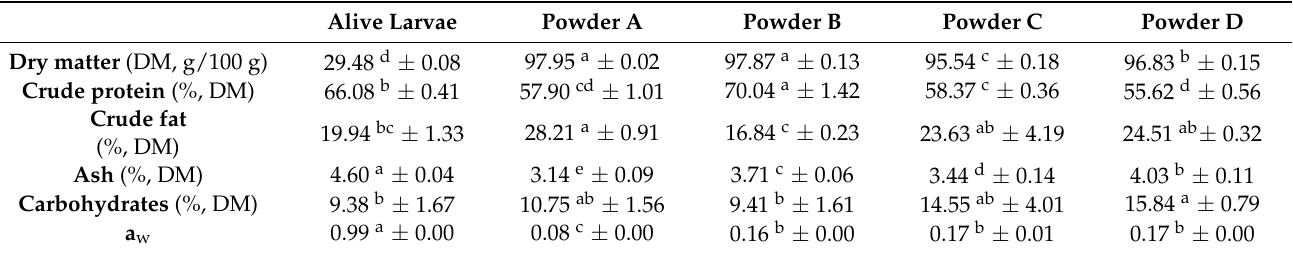
Table 4. Proximate composition and a w of fresh Tenebrio molitor (TM) larvae and different powders (Means ± standard